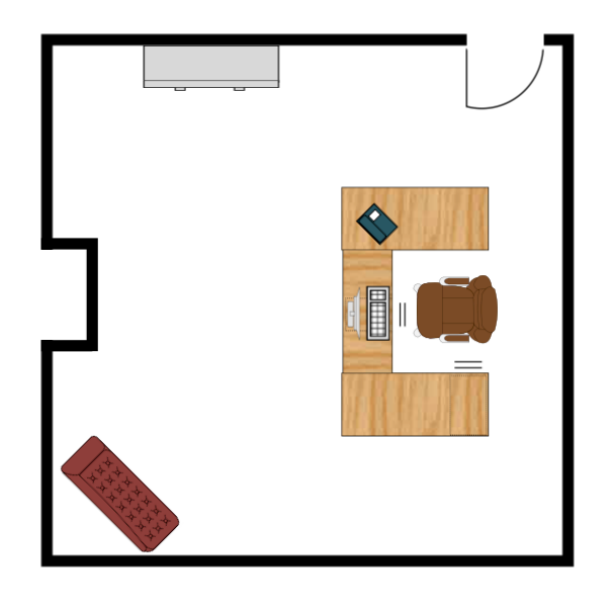
Figure 11. Example environment with planar obstacles and a wall protrusion.